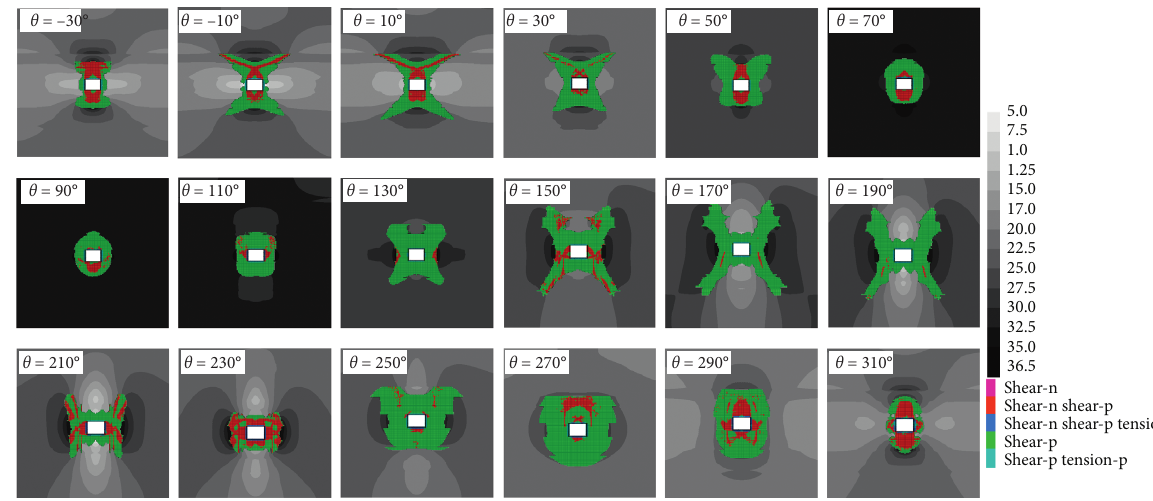
Figure 4: Principal stress difference and plastic zone distribution